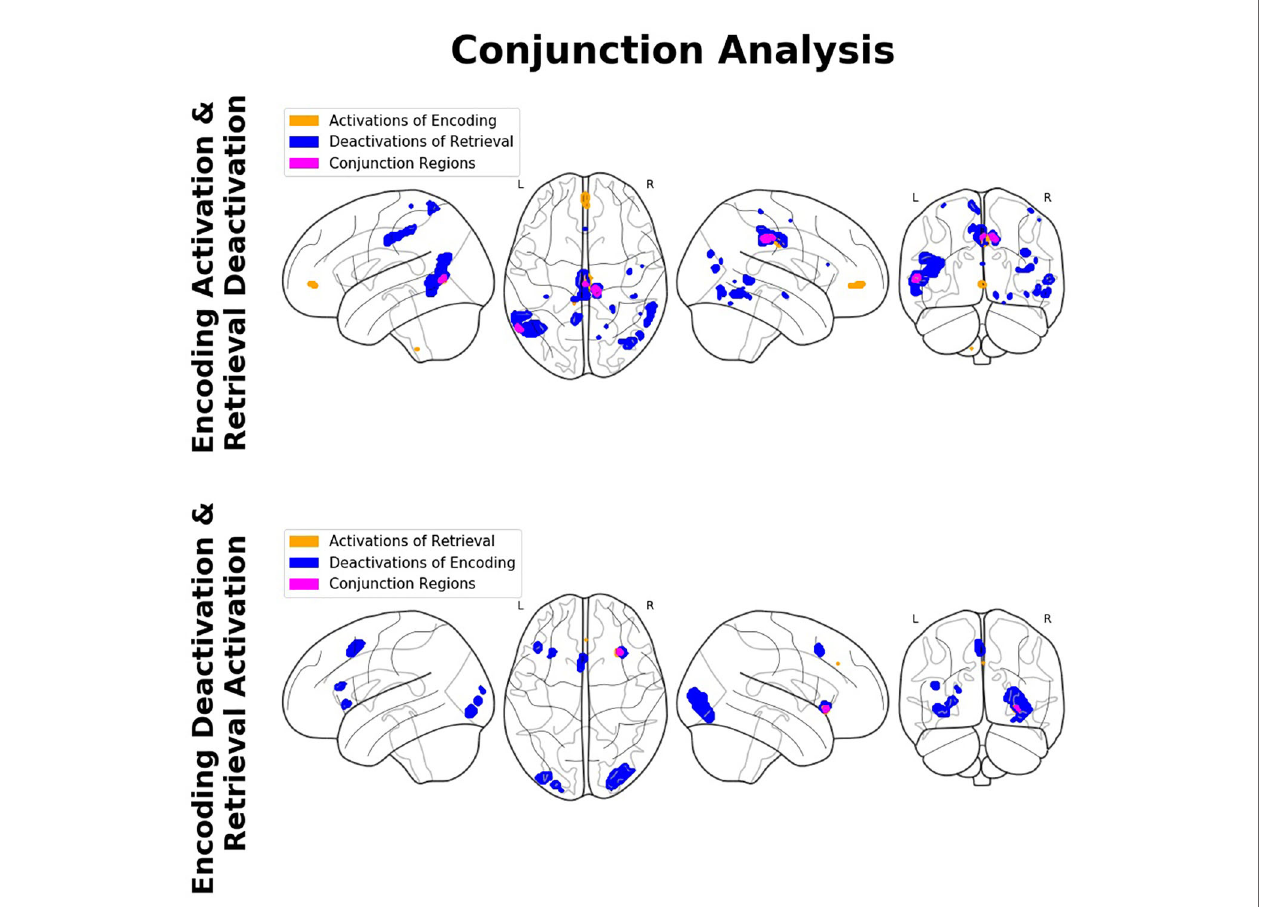
FIGURE 5 | Findings of the conjunction analyses: Glass brain renderings of activations (orange) and deactivations (blue) and their overlap (magenta) in relation to memory encoding and retrieval. Regions showing an overlap of antagonistic activation related to the complementary mnemonic sub-processes (i.e., activation in relation to the one and deactivation in relation to the other) constitute a so-called encoding/ fl ip (E/R) fl